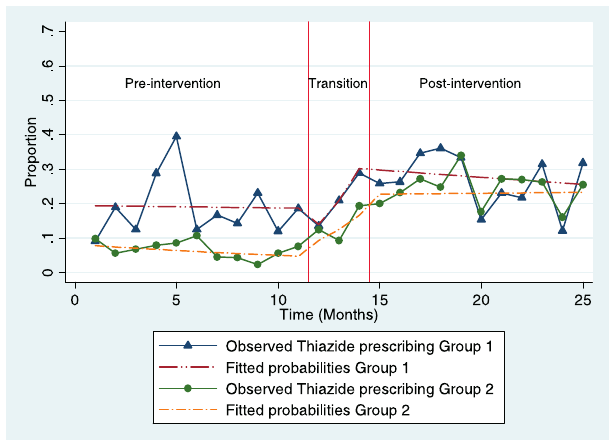
Figure 5. Proportion of Thiazide Prescriptions among Practices from Intervention Group in Earlier Trial (Group 1) and Other Practices (Group 2)